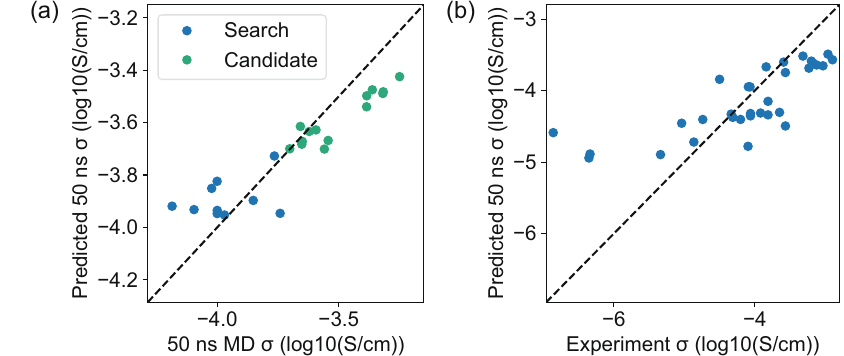
Fig. 5 Validation of the predicted polymers. a Validation of the best candidates from the search space (blue) and the candidate space (green). b Validation of the model prediction with out-of-distribution literature